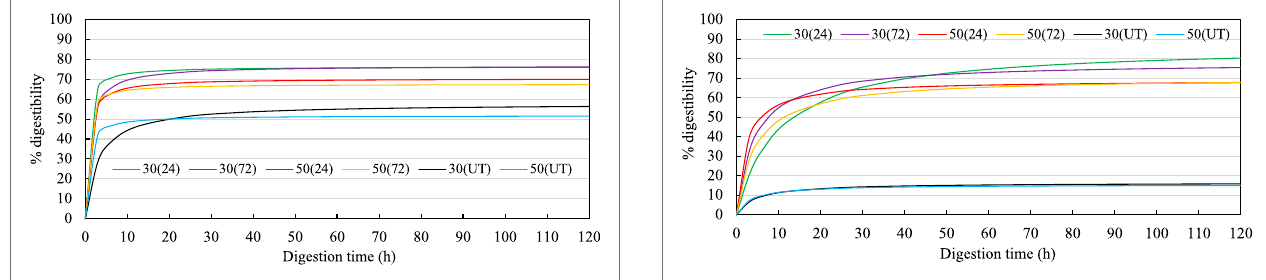
FIGURE 5 | Enzymatic digestibility curves for treated CF. In the legend, the fi rst numbers indicate the MC (%db), the numbers in the parentheses indicate the incubation time (h). Hanes-Woolf linear regressions used to estimate the digestibilites over time were 30 (24): Y (cid:2) 0.0115x + 0.1147; 30 (72): Y (cid:2) 0.0128x + 0.055; 50 (24): Y (cid:2) 0.0145x + 0.0328; 50 (72): Y (cid:2) 0.0142x + 0.0659; 30(UT): Y (cid:2) 0.0609x + 0.2771; 50(UT): Y (cid:2) 0.0647x + 0.2278. UT indicates untreated CF.